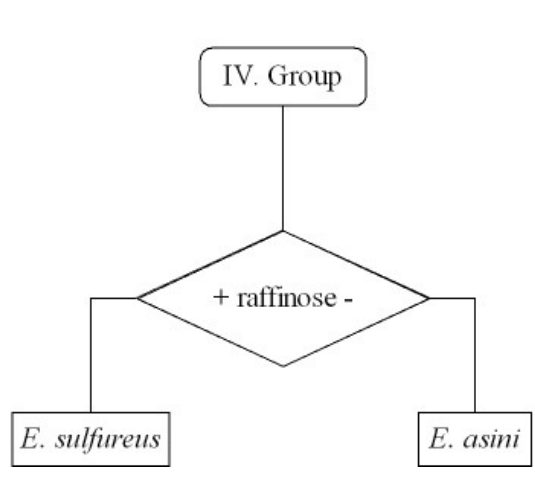
Figure 24. Identification of the members of group III. of enterococci by bio- chemical